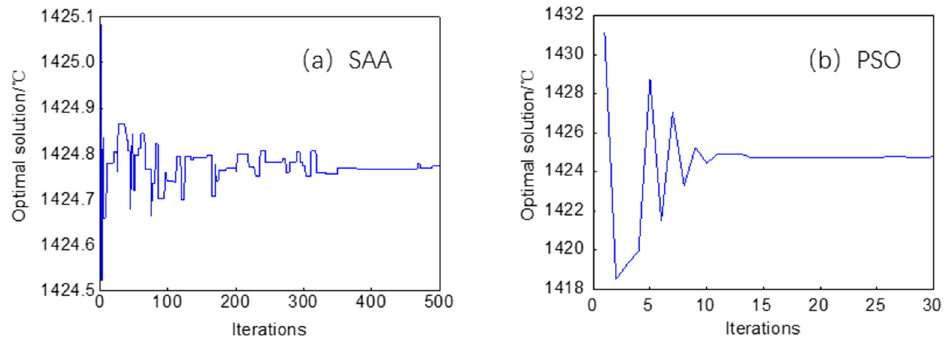
Figure 11. Iterations of optimization by ( a ) SAA and ( b ) PSO.